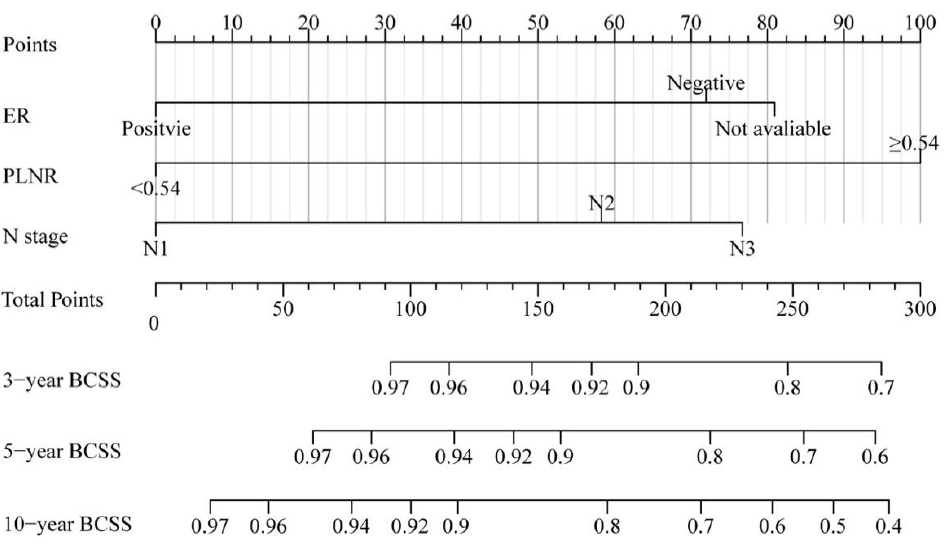
Figure 3. Nomogram model of BCSS in patients with OBC. Abbreviation: BCSS, breast-cancer-specific survival; OBC, occult breast cancer.